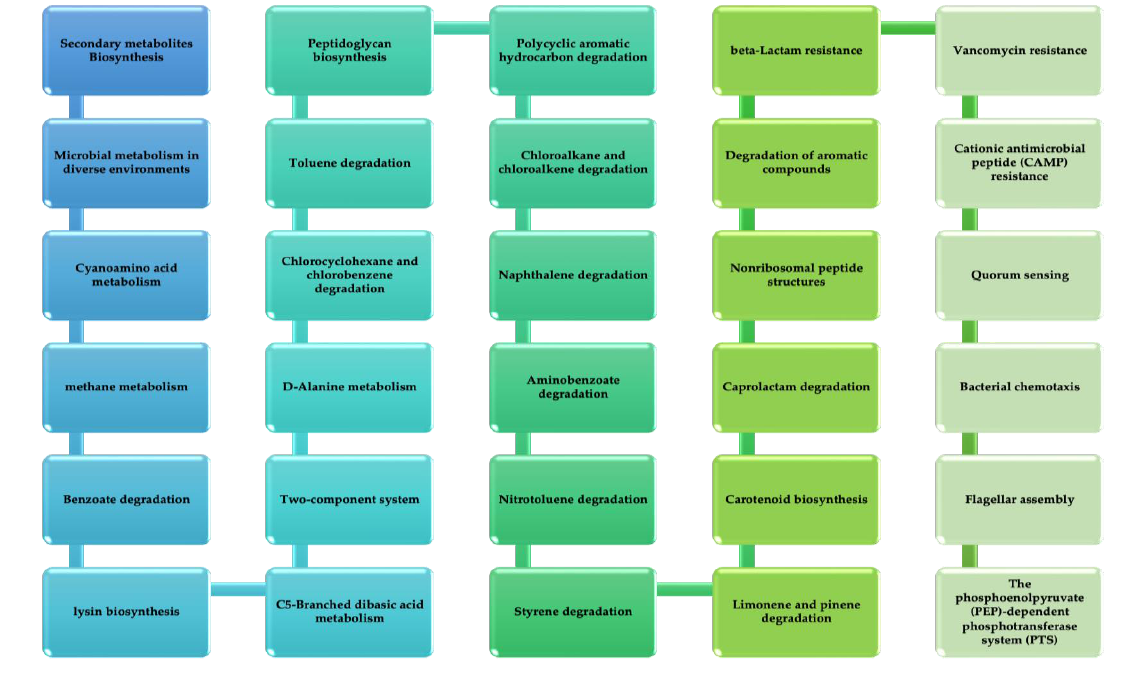
Figure 3. Unique metabolic pathways of B. pertussis from KEGG. Table 2. Non-similar vital proteins of B. pertussis strain B1917 similar to FDA-approved drugs against database of DrugBank using BLAST P.